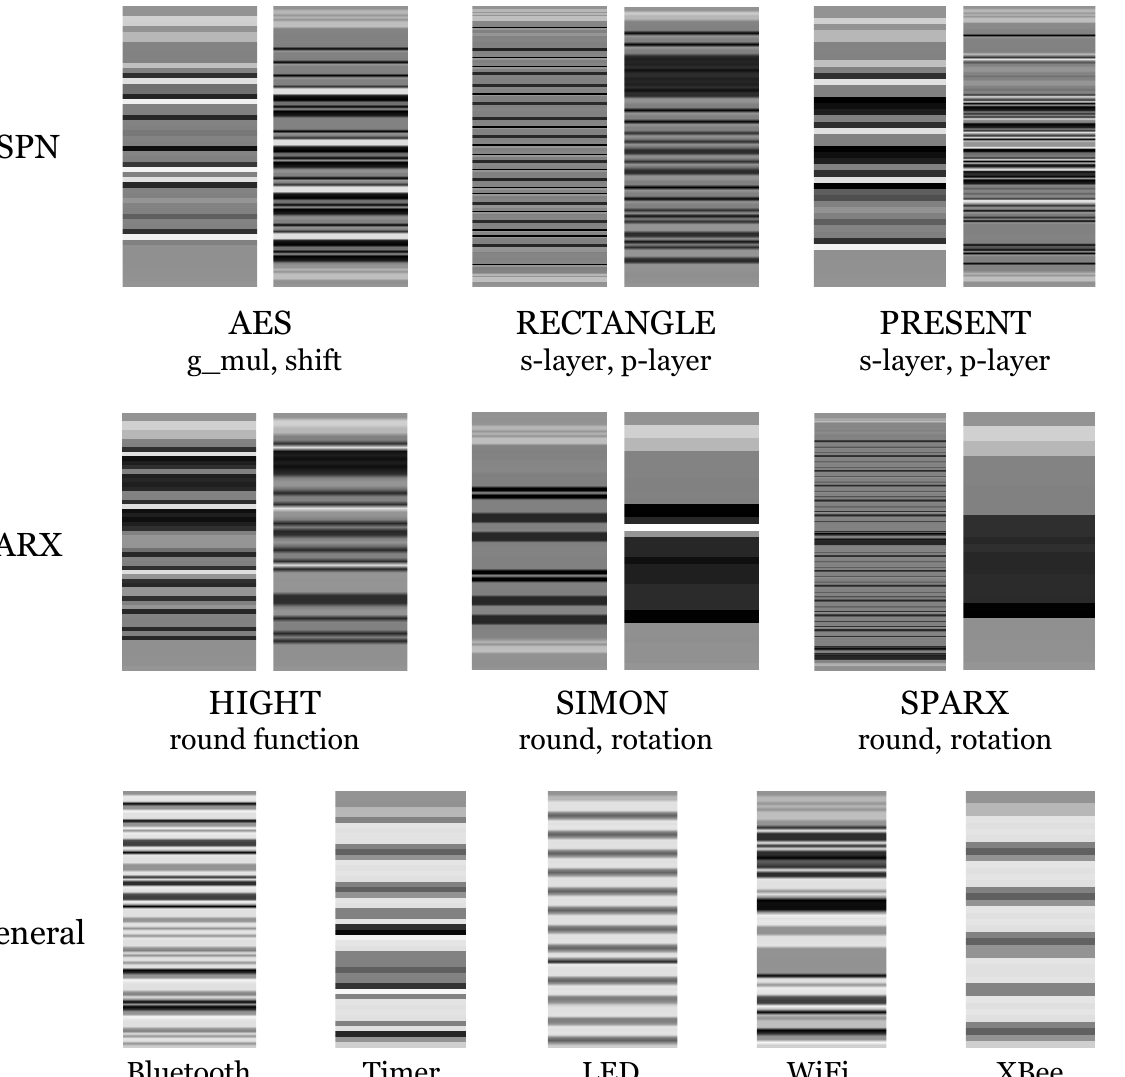
Figure 8. Visualization of binary images for each